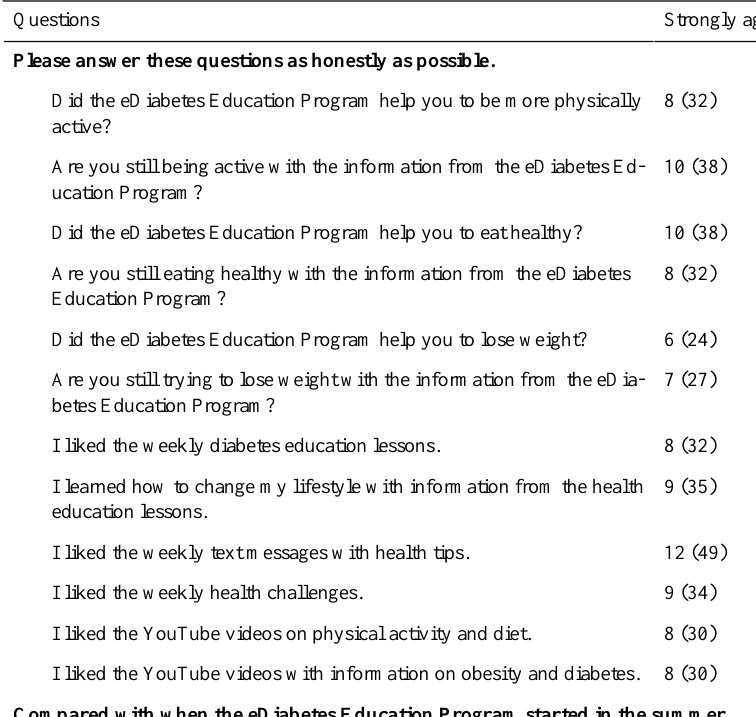
Table 6. Poststudy survey of the diabetes education program